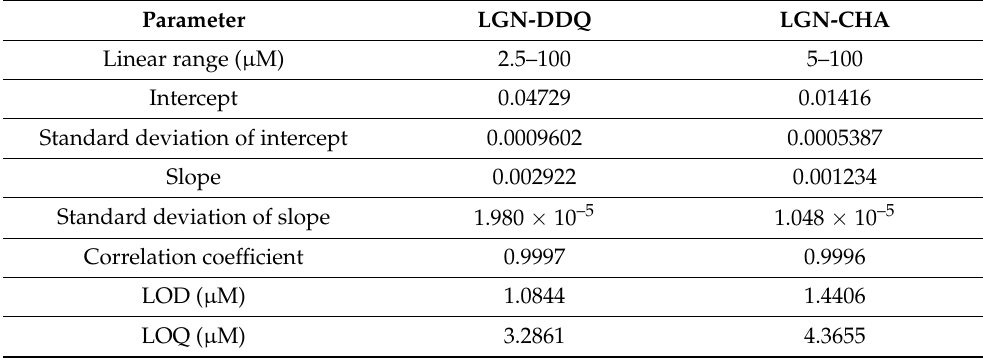
Table 4. Calibration and validation parameters for the determination of LGN by the proposed spectrophotometric method based on its formation of coloured complexes with DDQ and